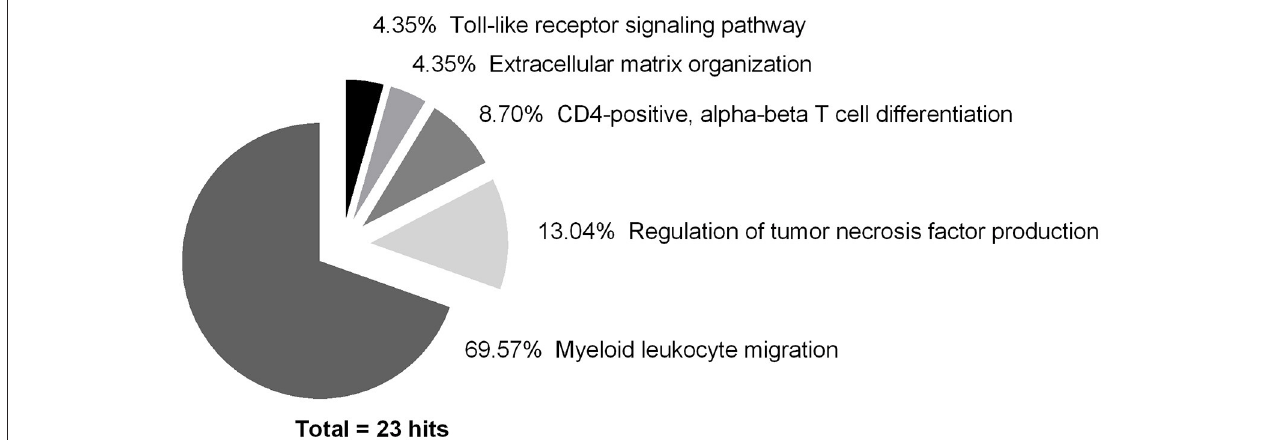
FIGURE 6 | Pathway analysis of differentially expressed genes showing the highest impact over the whole course of time (hits ≥ 3; 23 in total). Data was analyzed using ClueGO ( Bindea et al., 2009), a Cytoscape (Lotia et al., 2013) plugin designed by Bindea et al. (2009). Each association to an ontology was counted as one hit, regardless of gene